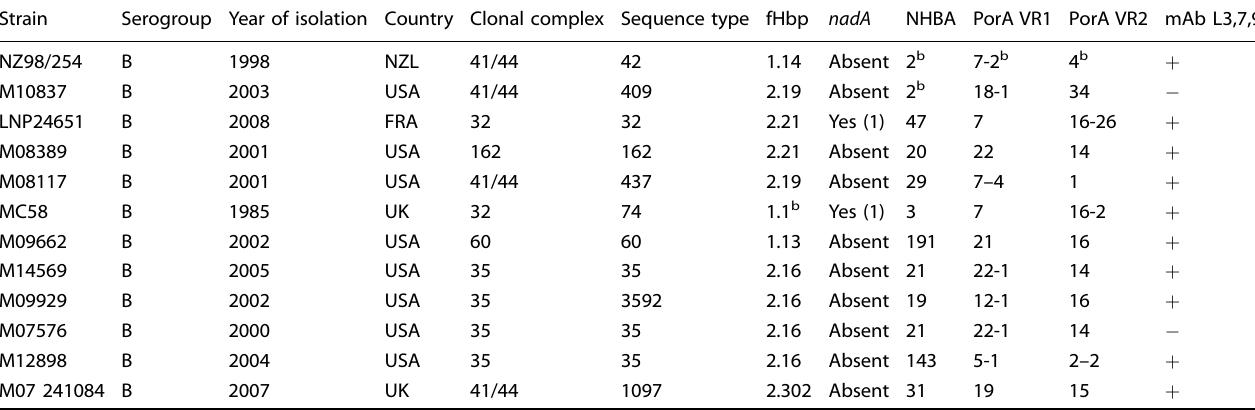
Table 1. Characteristics of serogroup B meningococcal strains used as target strains in SBA. Strain Serogroup Year of isolation Country Clonal complex Sequence type fHbp